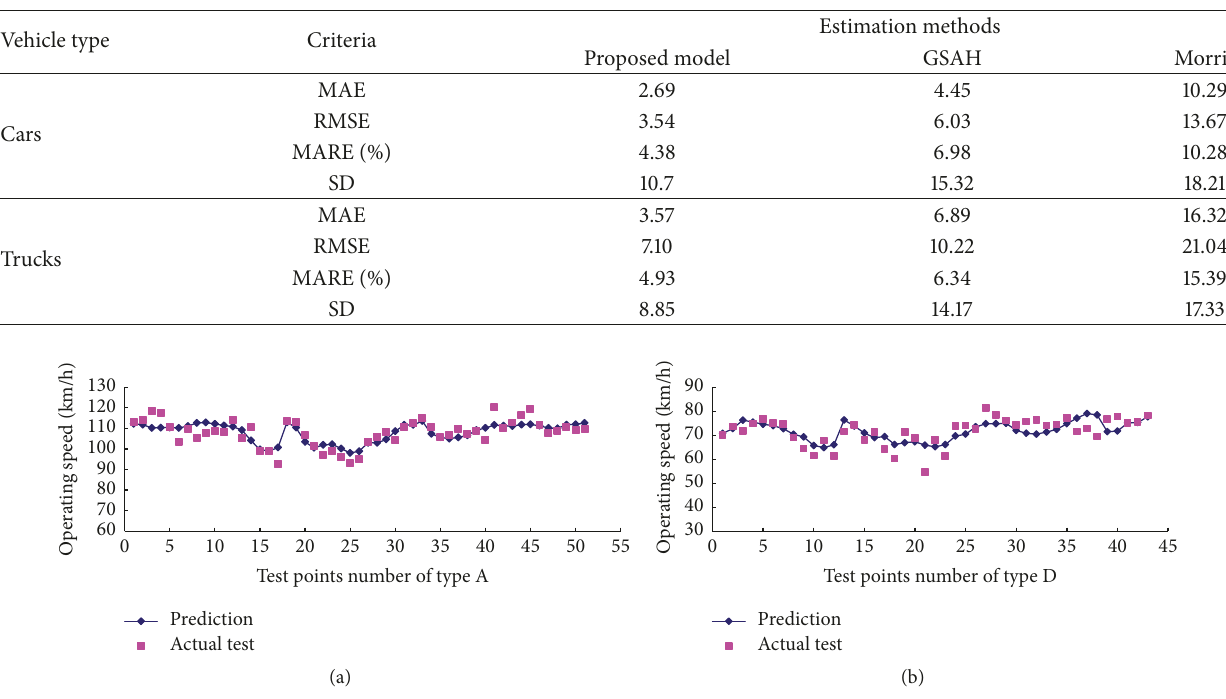
Figure 5: Comparison between predicted speed and actual speed. (a) Comparison for cars. (b) Comparison for trucks.